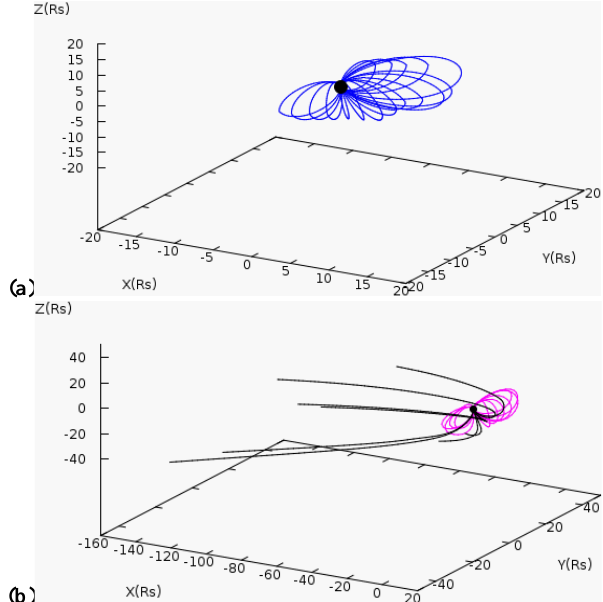
Fig. 5. Field lines mapping to (a) the equatorward and (b) the pole- ward boundary of the dayside UV auroral oval for image C with k s = 0 . 2, corresponding in the southern ionosphere to the positions indicated by the red crosses in Fig. 2. All the field lines in the model are closed (blue lines) for the equatorward boundary in panel (a) . For the poleward boundary in panel (b) , some of the field lines are closed (purple) and some are open